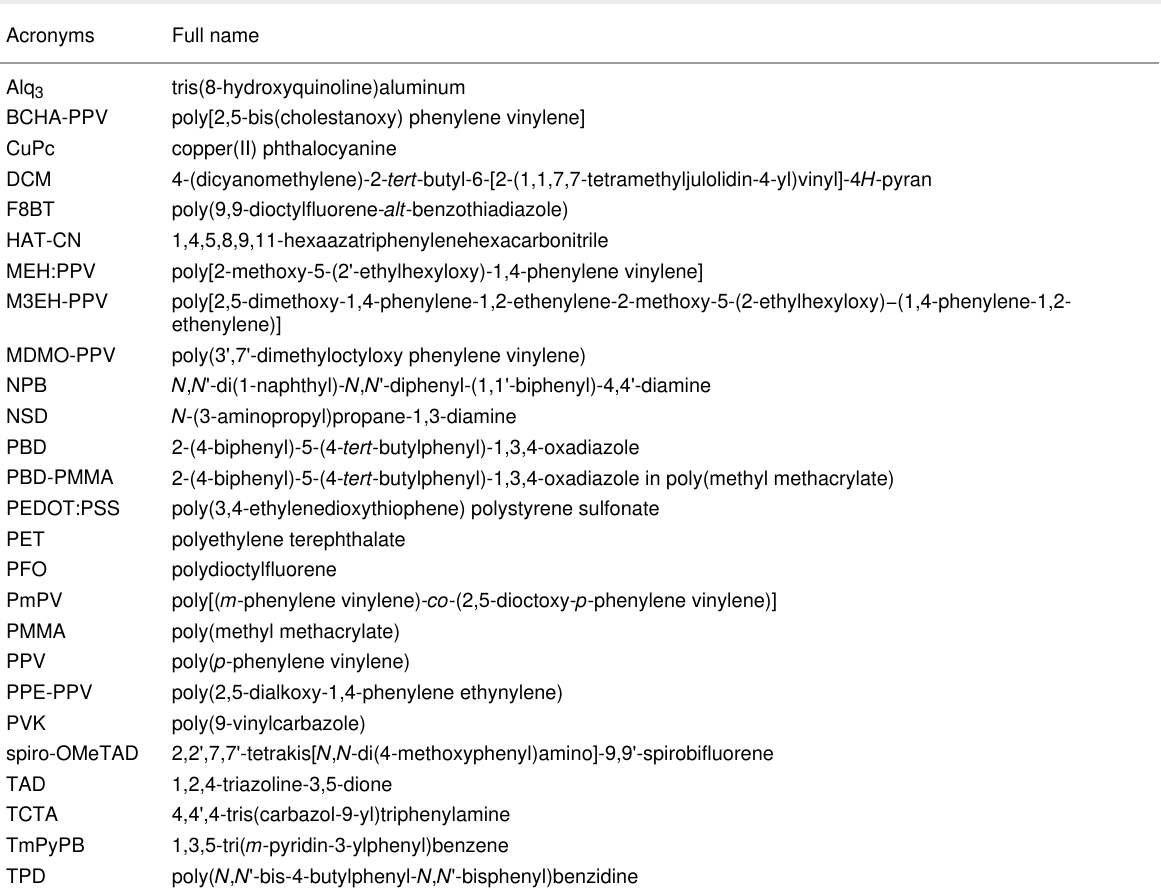
Table 2: List of polymers and their acronyms mentioned in this review.